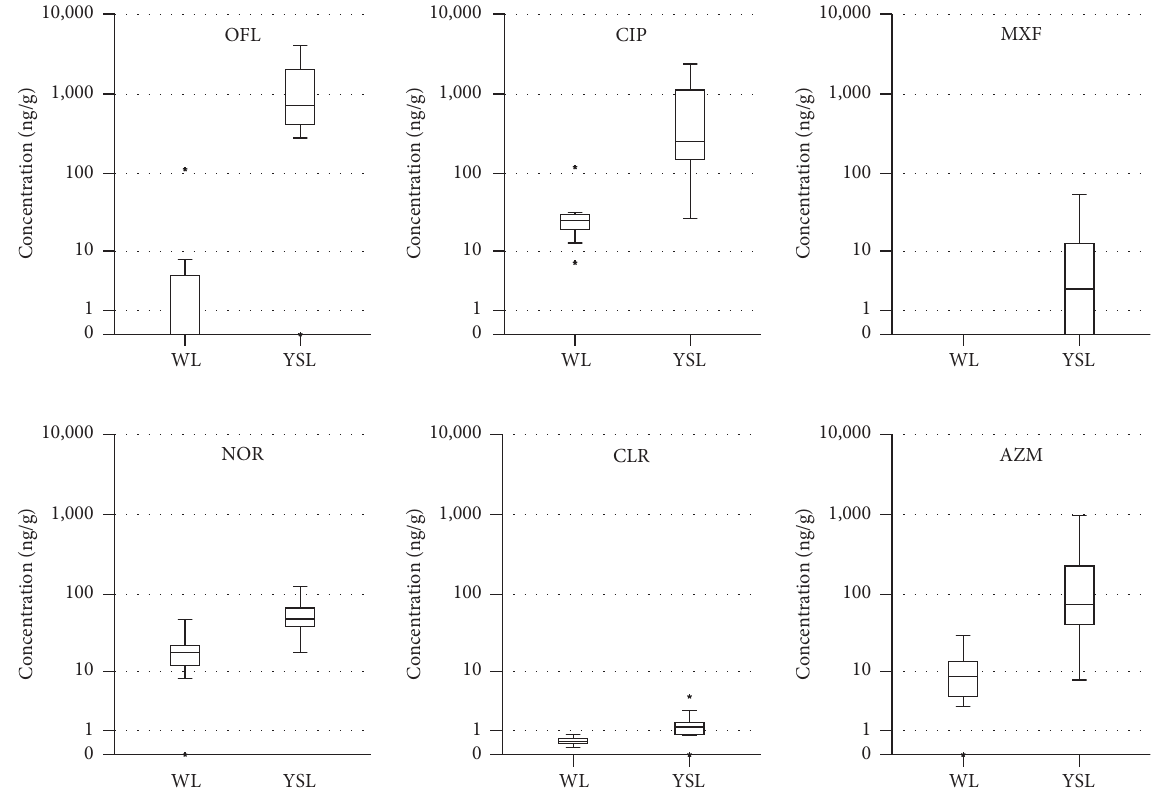
Figure 2: Box plot of antibiotic concentrations in sediment taken in West Lake ( n � 11) and Yen So Lake ( n � 14).